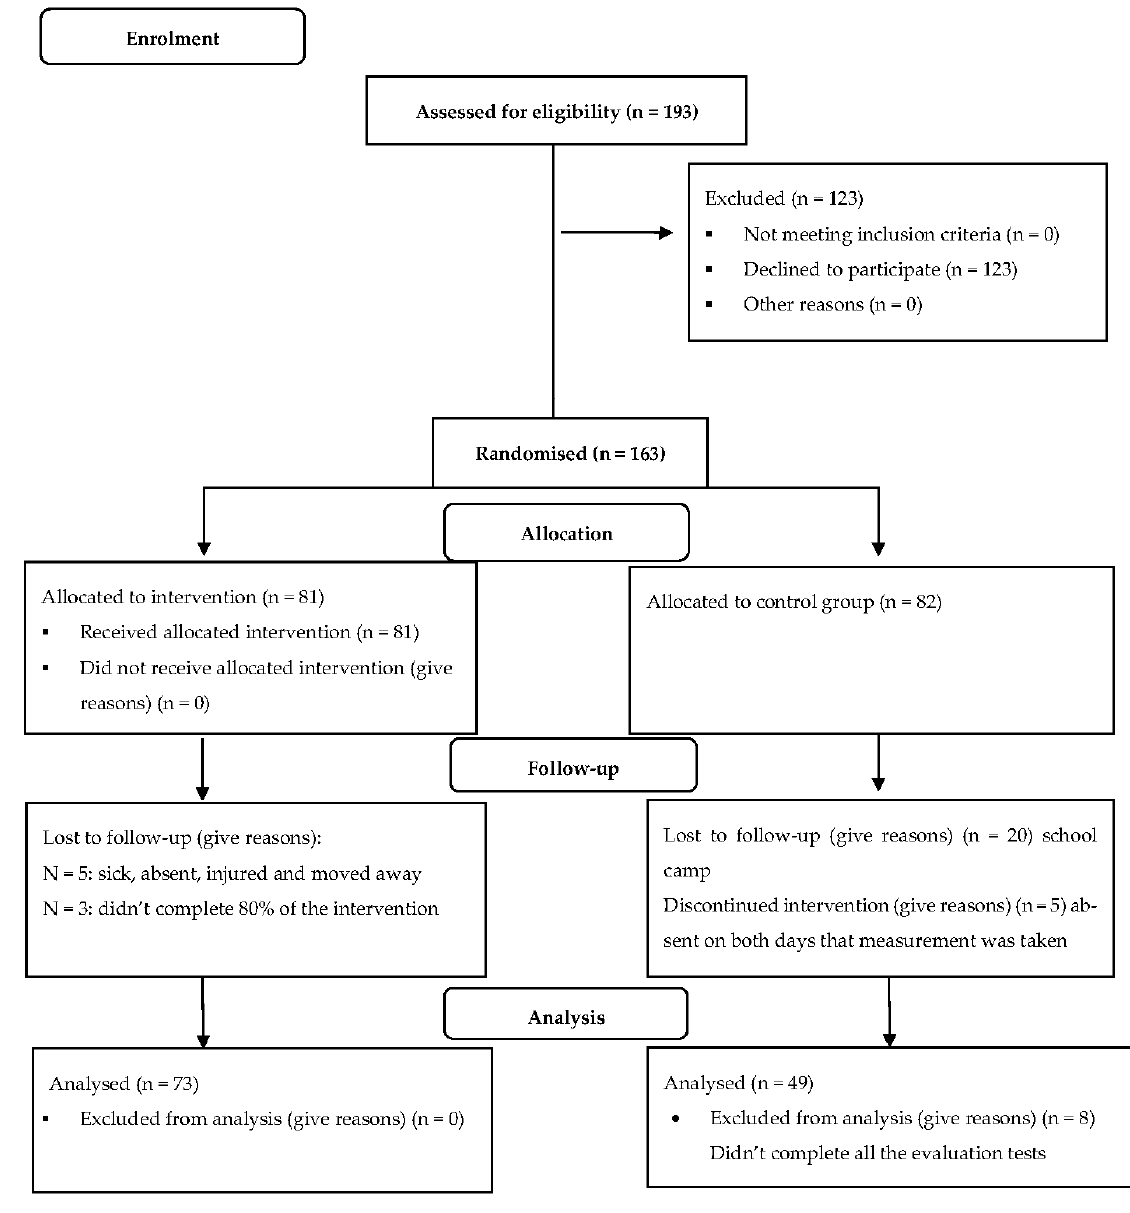
Figure 1. Flow diagram of the participants of this study.